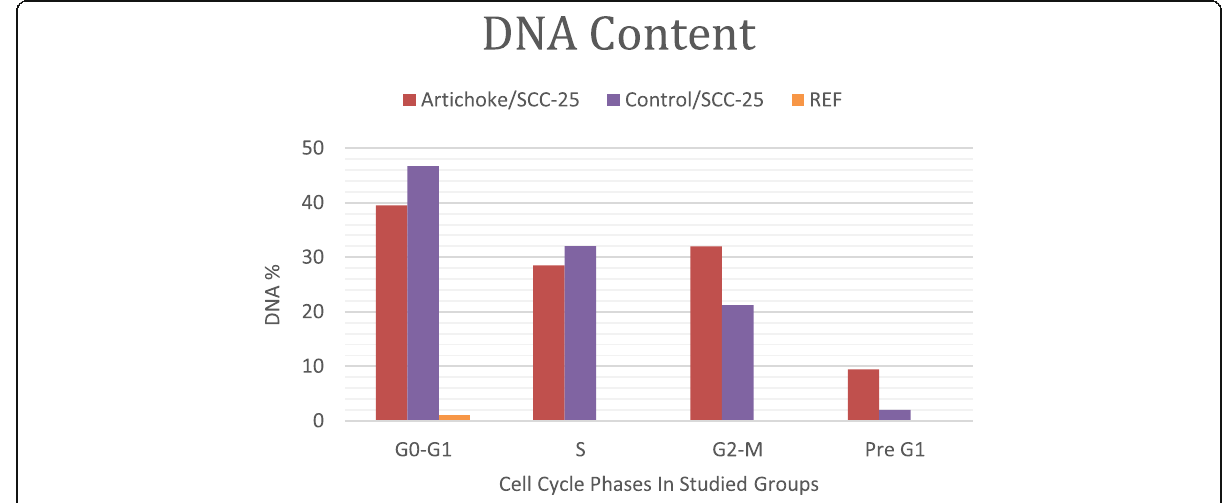
Fig. 6 Percentage of DNA content in control and artichoke SCC cell lines during flow cytometry cell cycle